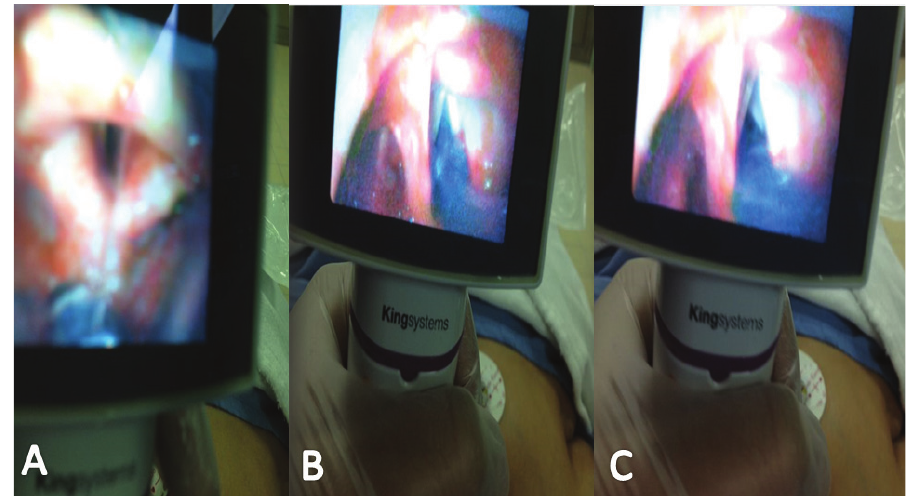
Figure 2. Photograph showing a bronchial tip of a left 35 Fr double-lumen tube (DLT) passing towards ( A ) and through ( B ) the vocal cords, and ( C ) following removal of the stylet and 180° counterclockwise rotation of the DLT through the display unit of a King Vision™